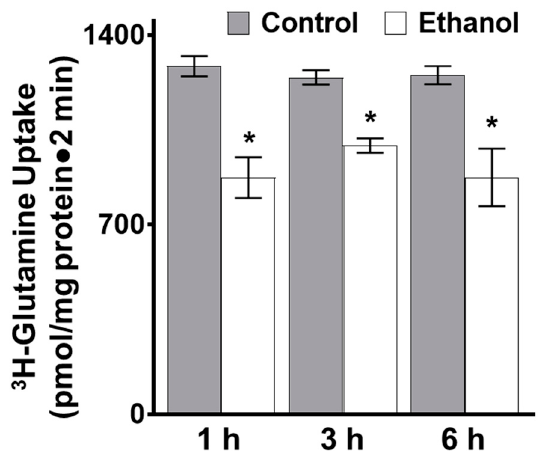
Figure 6. Moderate ethanol significantly inhibited glutamine absorption in IEC-18 cells. Sodium-dependent glutamine activity was determined using 3 H-glutamine uptakes with and without a sodium-free condition in the presence and absence of moderate ethanol (* p < 0.05, n = 6). The error bars represent the SEM. P-values were adjusted for multiple hypotheses using a Bonferroni correction (1 h: p < 0.01; 3 h: p < 0.05; 6 h: p < 0.01).